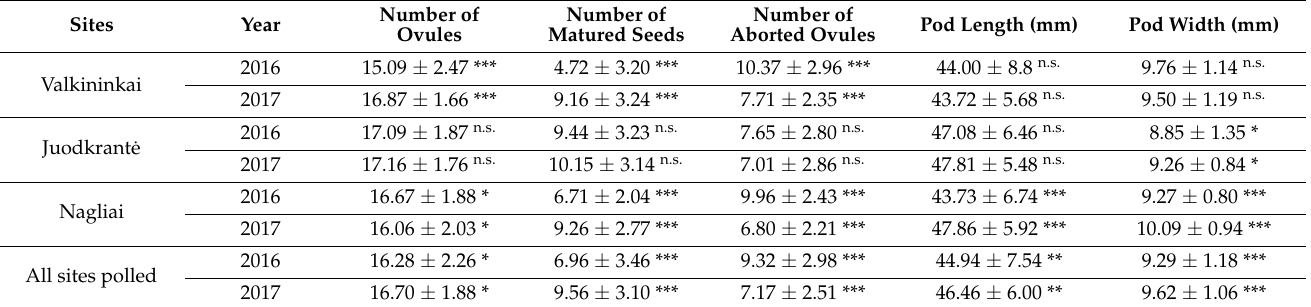
Table 3. Comparison of reproductive traits of Cytisus scoparius at three sites in 2016 and 2017. Data includes mean values and standard deviation. Differences between different years at the same